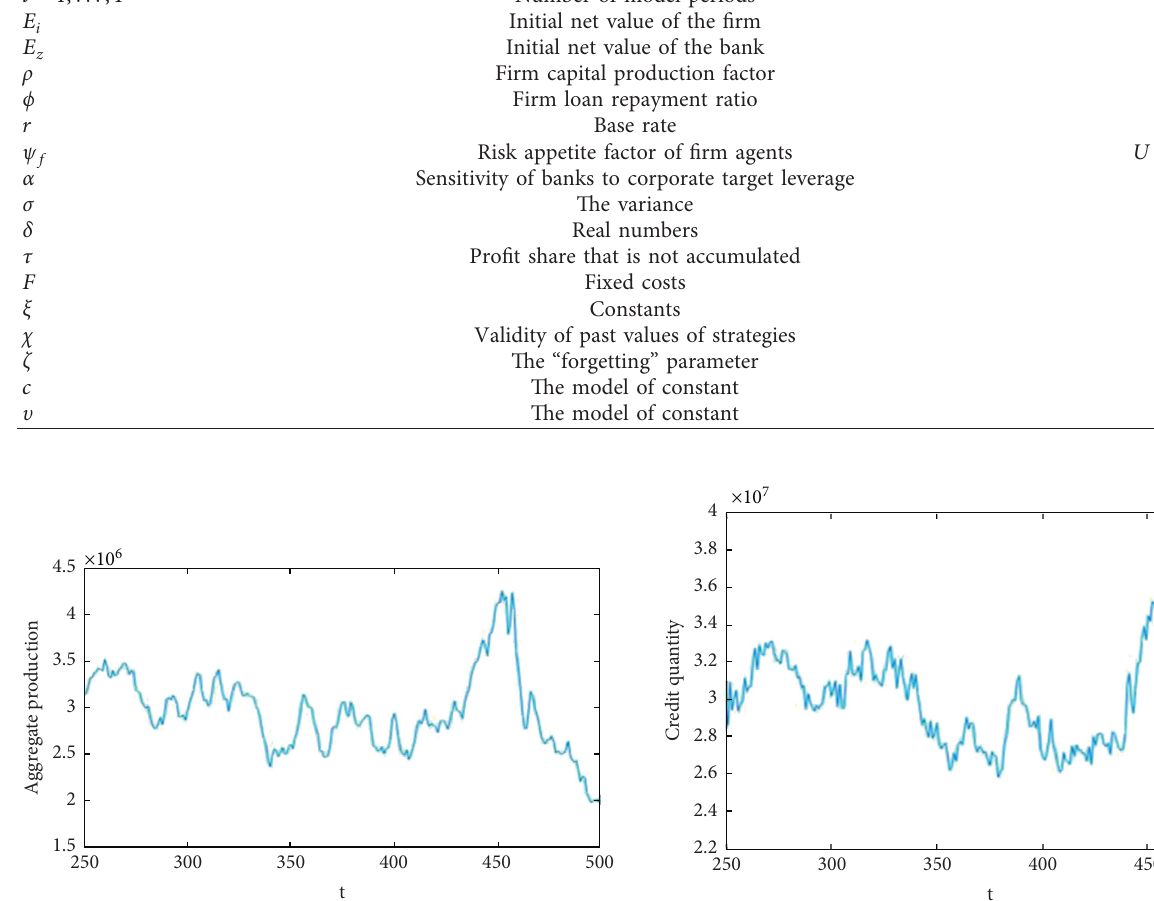
Figure 2: Time series evolution of aggregate production. Figure 3: Time series evolution of credit quantity.